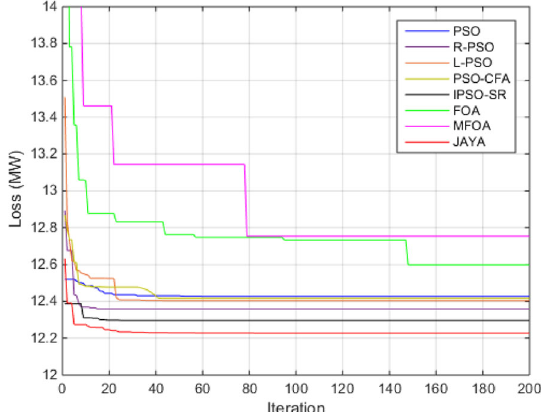
Fig. 2 Convergence characteristics of the algorithms for the IEEE 14 bus system without DG injection